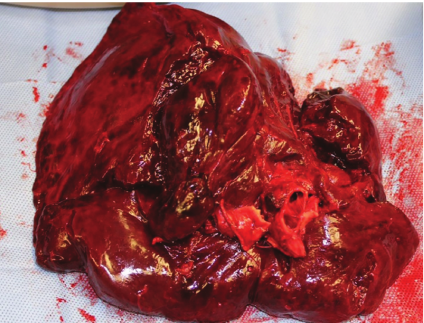
Figure 5: Gross appearance of left lower lobe following left pneu- monectomy